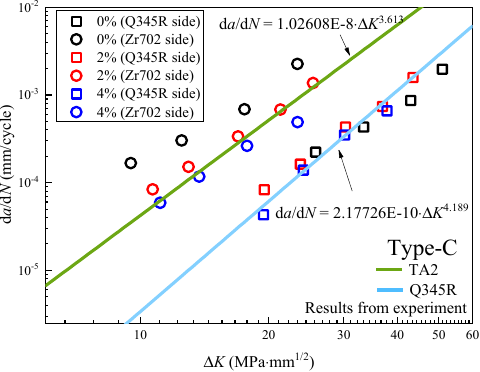
Figure 14. Effect of pre-strain on crack growth characteristics for cracks on both sides.